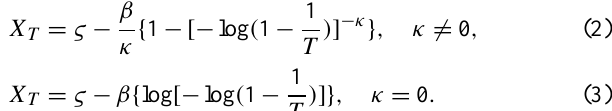
Fig. 1. Study area and location of meteorological